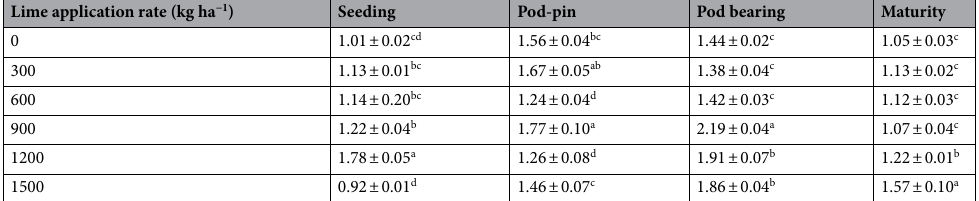
Lime application rate (kg ha −1